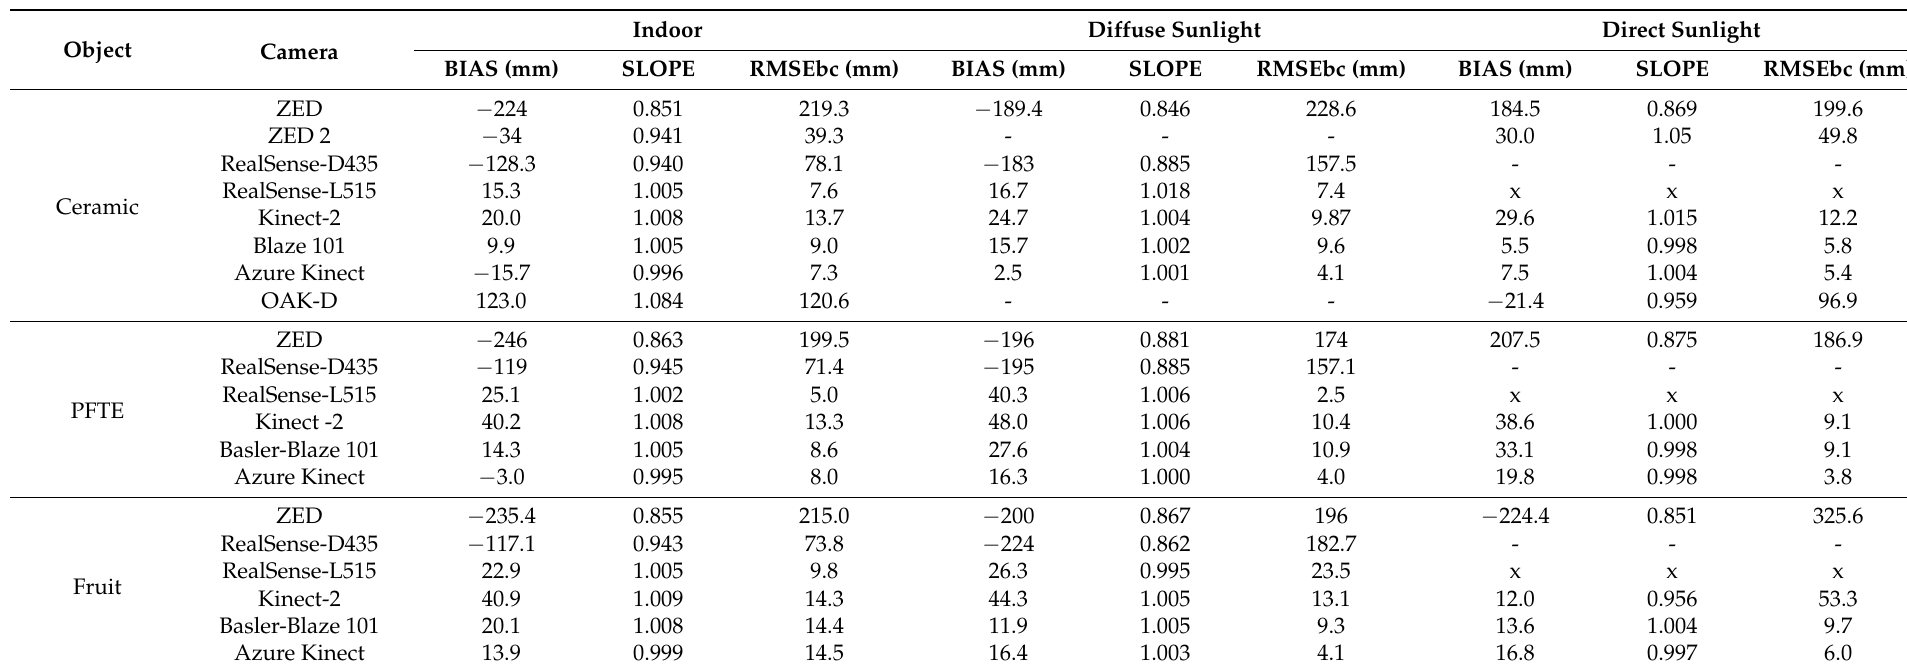
Table 2. Depth measurement results for indoor, diffuse, and direct solar lighting conditions, for measurements of camera to three objects made at 50 cm intervals to 5 m. RMSEbc is bias-corrected root mean square of error. ‘x’ in Table represents measurements that could not be achieved under the stated conditions and ‘-’ represents data not collected. In the direct sunlight condition, the object was in sunlight and the camera in